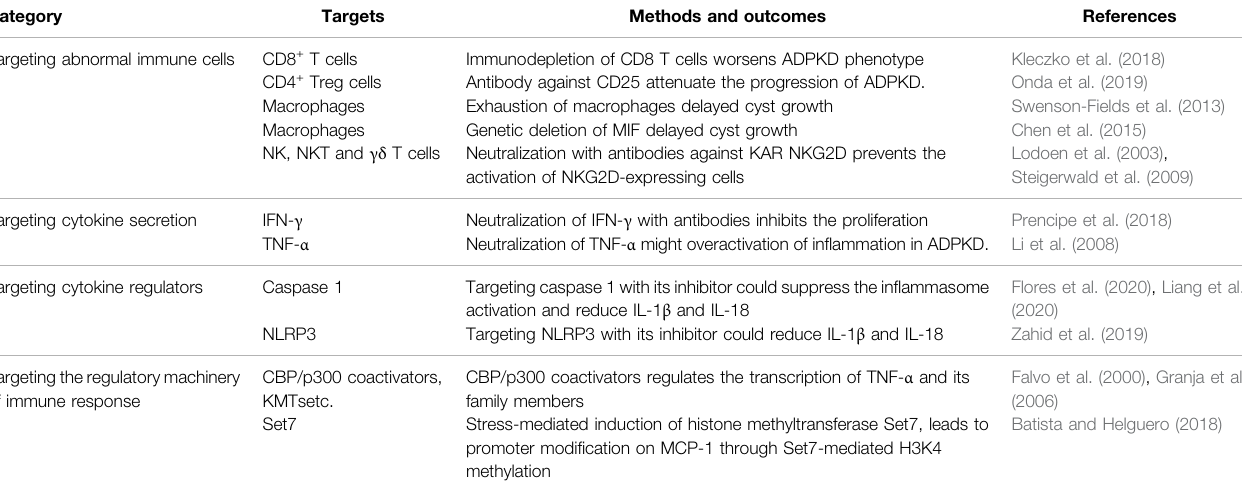
TABLE 3 | Prospective immunotherapy strategies in the treatment of